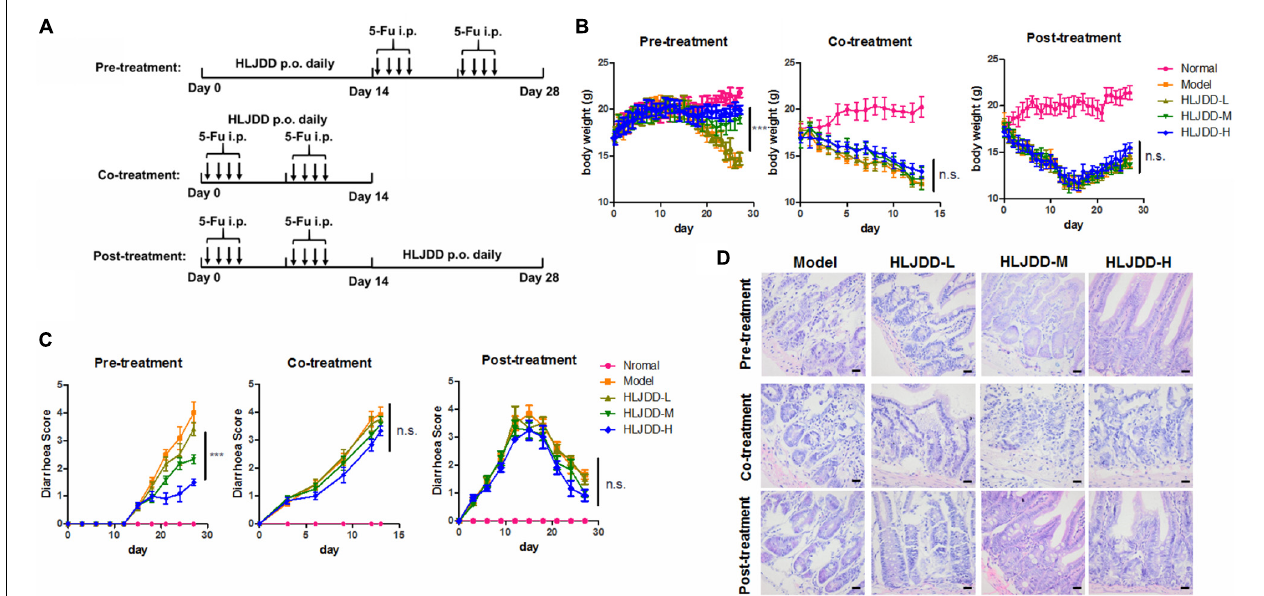
FIGURE 2 | Pre-treatment but not co-treatment or post-treatment of HLJDD improved 5-Fu-induced diarrhea. (A) Showed the treatment scheme; (B) showed that pre-treatment but not co-treatment or post-treatment of HLJDD improved body weight loss induced by 5-Fu; (C) showed that pre-treatment but not co-treatment or post-treatment of HLJDD improved diarrhea score induced by 5-Fu; (D) showed that pre-treatment but not co-treatment or post-treatment of HLJDD improved the histological structure of jejunum damaged by 5-Fu. *** p < 0.001 when compared with the model group.